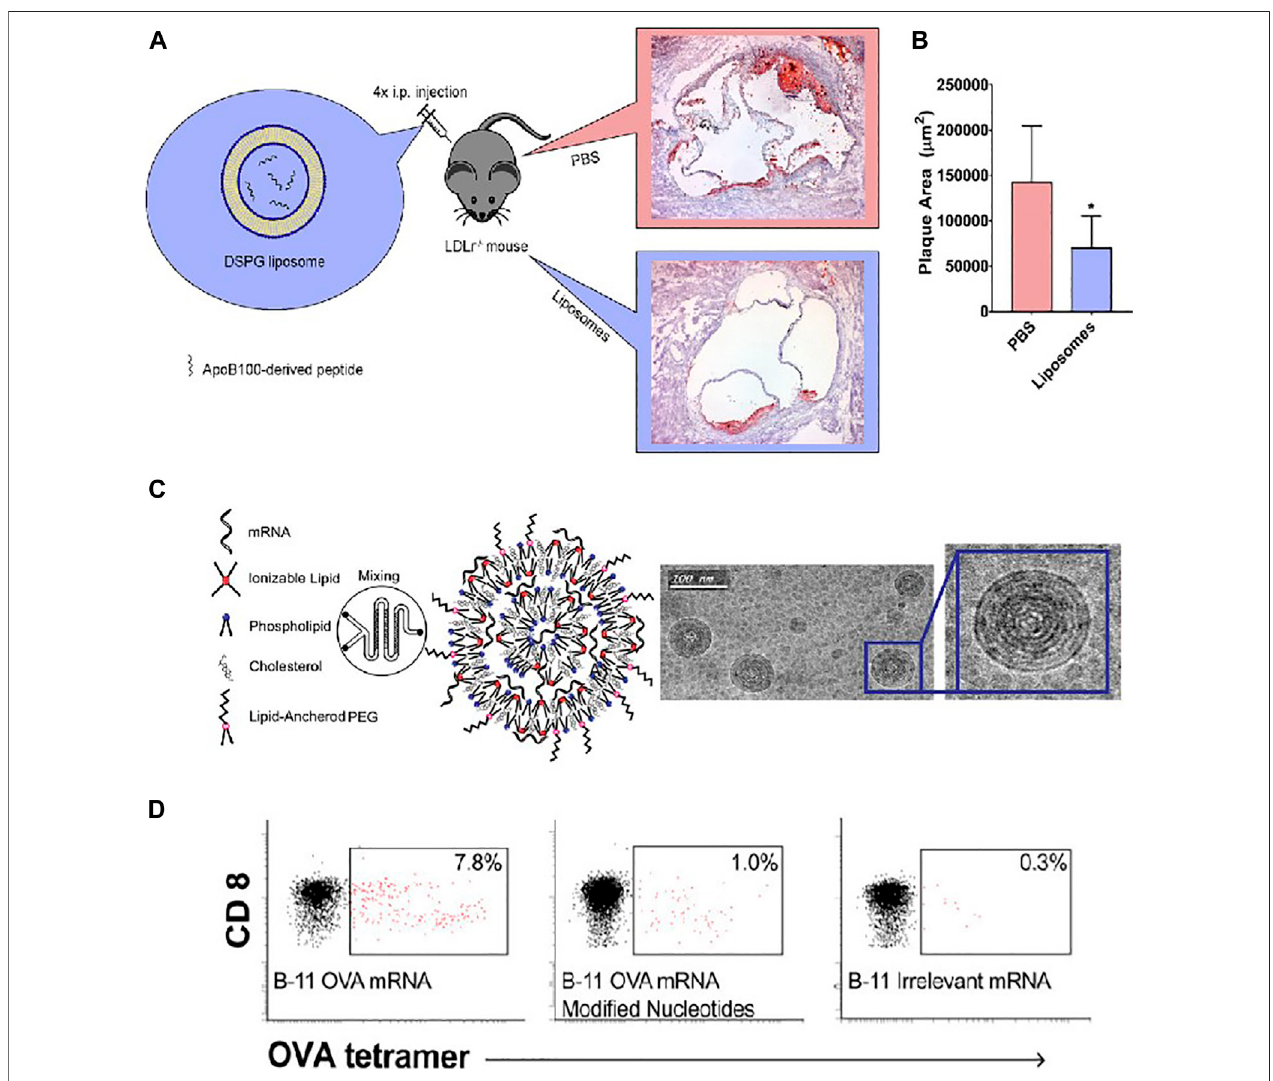
FIGURE6 |(A) Representativeimagesofsections oftheaorticvalve areain amouse receiving PBSor DSPG/p3500-liposomes. (B) Lesion areaas determined by Oil-Red-O staining in a mouse receiving PBS or DSPG/p3500-liposomes. (C) “ Sandwich ” structure and Cryogenic transmission electron microscopy image of the LNP solution. (D) Representative FACS pro fi les of mice treated with the indicated conditions. (A,B) is reprinted with permission from reference. (Benne et al., 2018). (C,D) is reprinted with permission from reference (Oberli et al.,